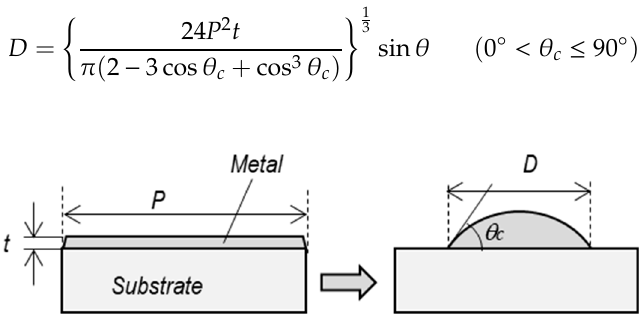
Figure 5. Geometrical change of a nanodot by thermal dewetting.